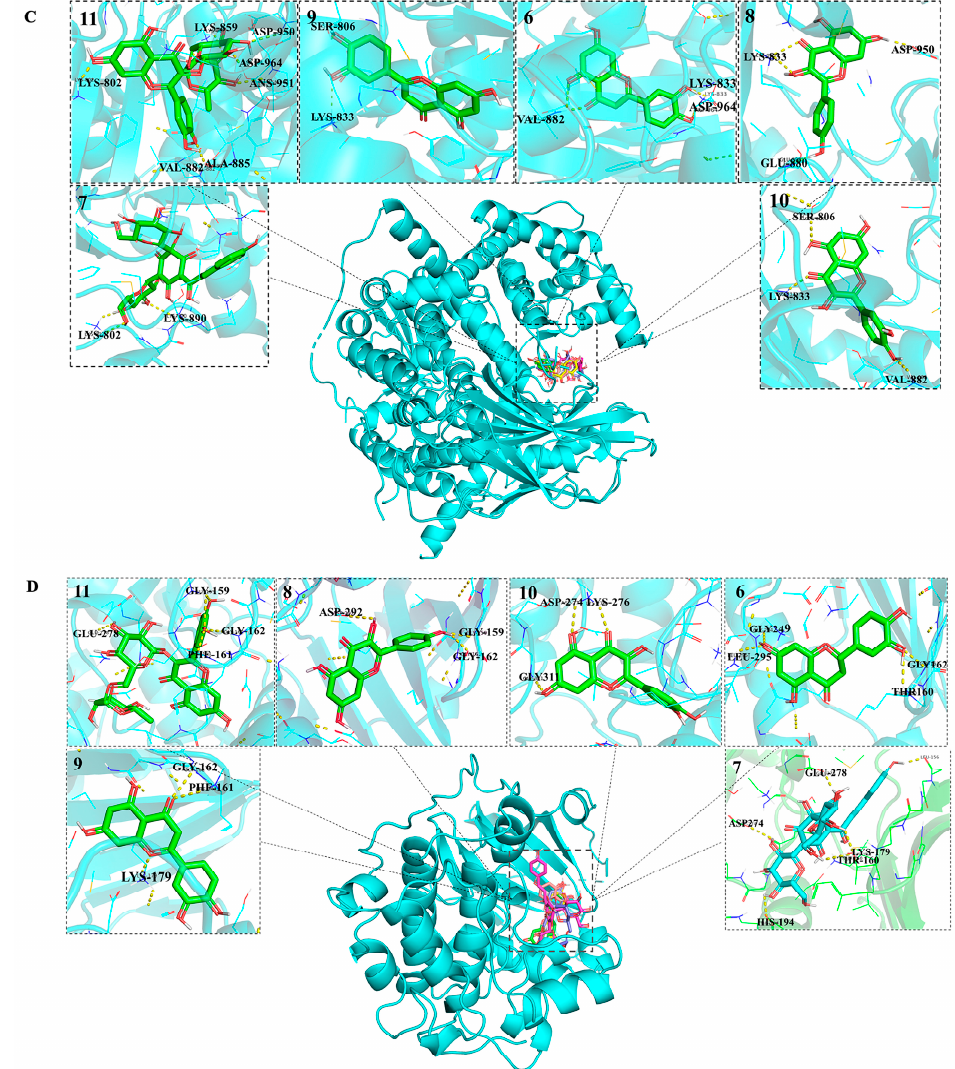
Figure 6. A diagram of mechanism of safflower in the treatment of MIR injury with the hub targets, key components, and crucial signaling pathways ( A ). Molecular docking simulation of the binding patterns of PRKCA ( B ), PIK3CG ( C ), and AKT1 ( D ) with the key components, including 6-hydroxyapigenin, 6-hydroxykaempferol-3-rutinoside-6-glucoside, 6-hydroxykaempferol, apigenin, baicalin, eriodictyol, HSYA, kaempferol, luteolin, quercetin, and rutin, respectively. Caption: 1. 6-hydroxyapigenin; 2. 6-Hydroxykaempferol-3-rutinoside-6-glucoside; 3. 6-Hydroxykaempferol; 4. Apigenin; 5. Baicalin; 6. Eriodictyol; 7. HSYA; 8. Kaempferol; 9. Luteolin; 10. Quercetin; 11. Rutin.